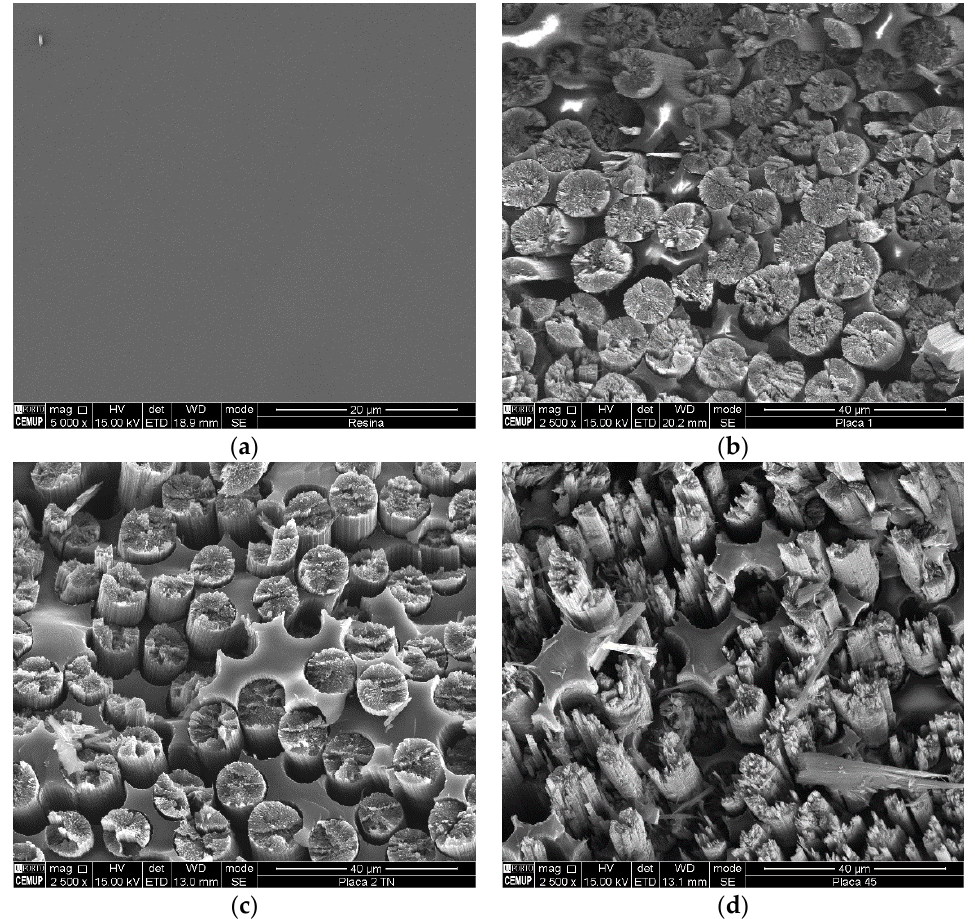
Figure 13. SEM micrographs of technological samples ( a ) resin ( b ) panel A ( c ) panel B ( d ) Panel Table 16. Summary of structure observation of CFRP technological samples.